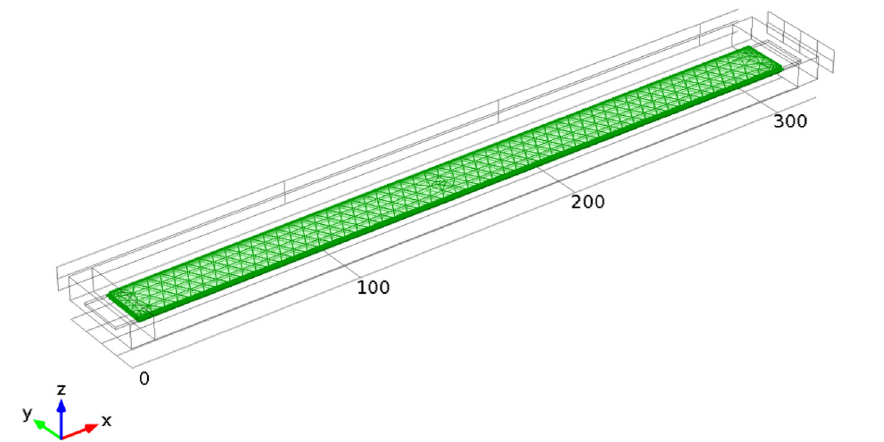
Figure 4. Fixed-fixed beam MEMS model geometry and its FEM